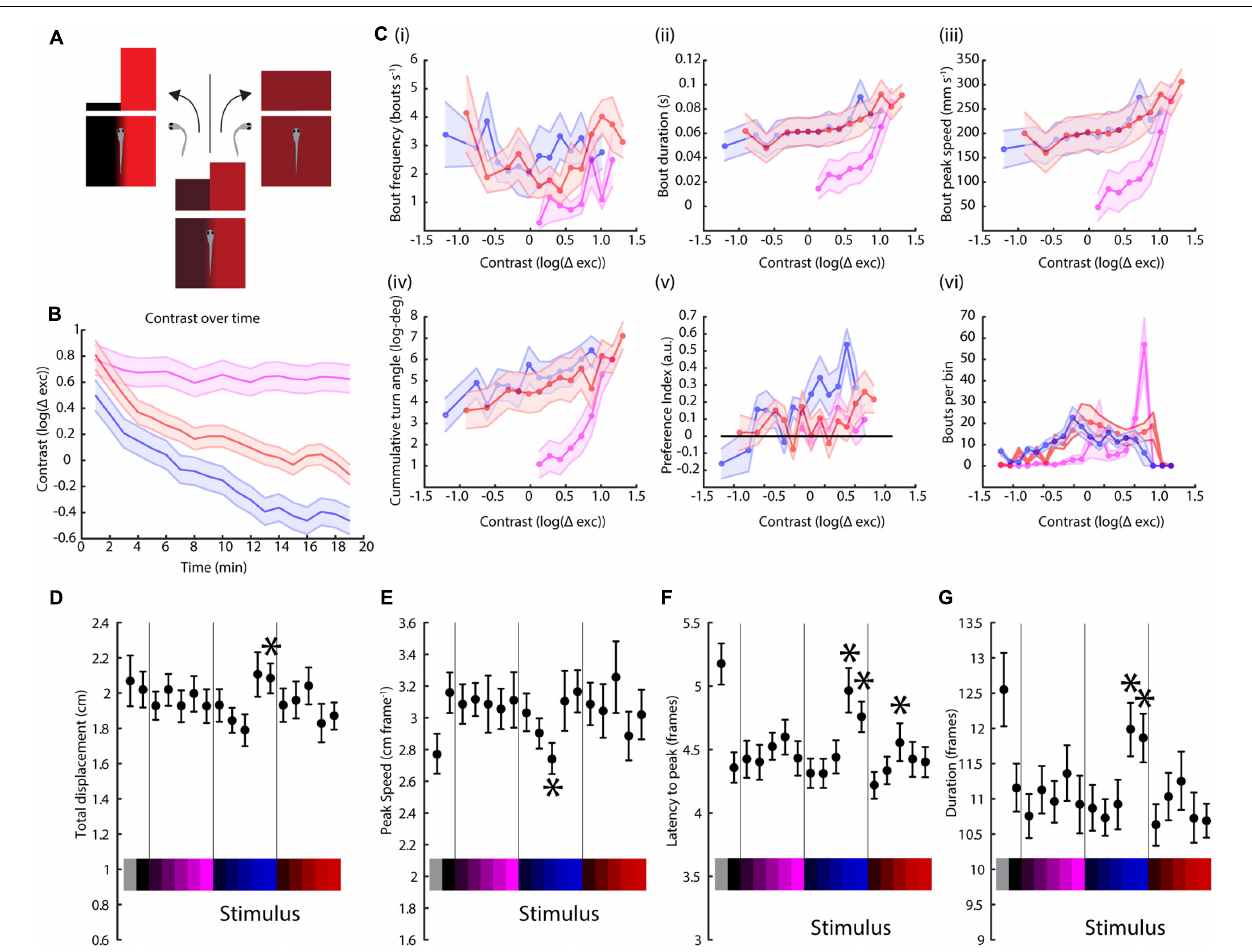
FIGURE 4 | Contrast variation but not full field stimulation have wavelength-dependent effects on swimming parameters. (A) Schematic of the modified paradigm used. Briefly, the animal is presented with a split field stimulus as in the figures above, but now the contrast between the two sides decreases if the fish turns toward the lighter side (higher irradiance) and increases if the turn is toward the darker side (lower irradiance). (B) Contrast of each stimulus (UV, blue and red, colored as before) over time, averaged over two trials per experiment and 14 TLAB fish (the lines are mean ± SEM). The units are the logarithm of the total cone excitation difference between the two sides. (C) Modulation of (i) bout frequency, (ii) duration, (iii) peak speed, (iv) turn angle, (v) preference index, and (vi) number of bouts by stimulus contrast (points are averages across 14 animals ± SEM). (D–G) Dependency of bout displacement (D) , speed (E) , latency (F) , and duration (G) on full field stimulation (points are mean ± SEM, N = 23, stars represent a p -value < 0.05 on a paired bootstrap test against the first power level).